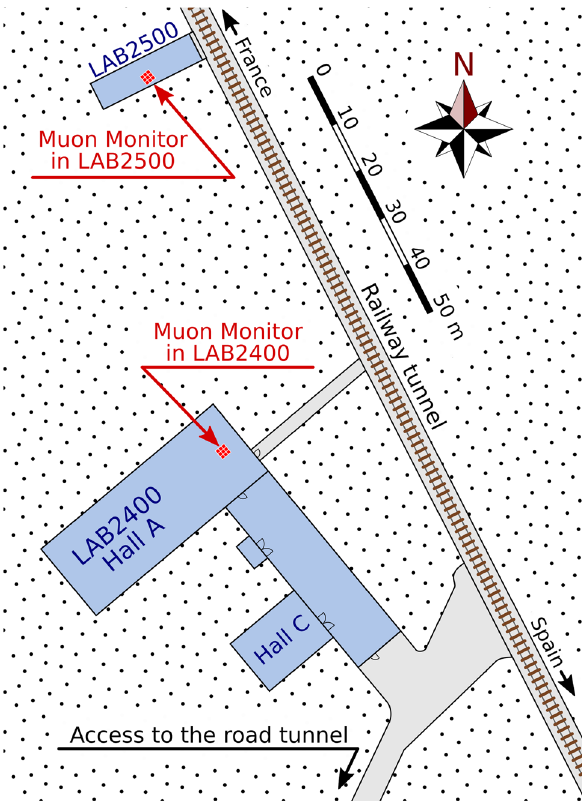
Fig. 4 Position of the Muon Monitor during the measurements at both locations